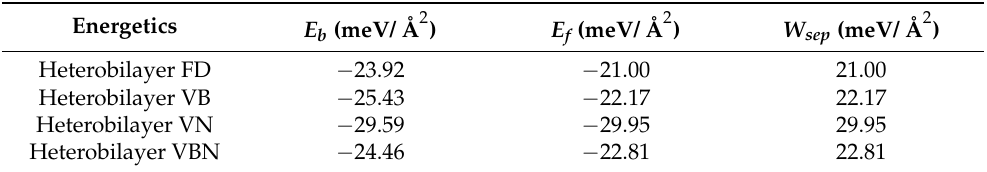
Table 3. Energetics in the h-BN/graphene heterobilayer, FD, and with 1 V B , 1 V N , and V BN , respec- tively. The energy is given in units of meV/ 2